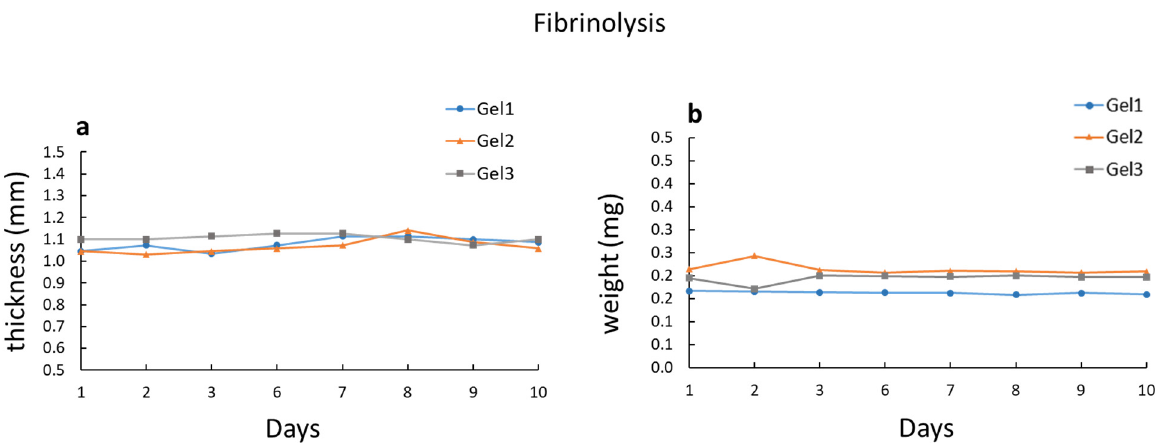
Figure 4. ( a ) Degradation of gel with cells. Gel degradation was estimated in the 3 types of gel by measuring gel thickness for 10 days after seeding cells. ( b ) Degradation of gel without cells, kept at 37°C in culture medium. Gel degradation was estimated in the 3 types of gel by measuring gel weight for 10 days. Gel 1 = 15 mg/mL fibrinogen; Gel 2 = 20 mg/mL fibrinogen; Gel 3 = 25 mg/mL fibrinogen.